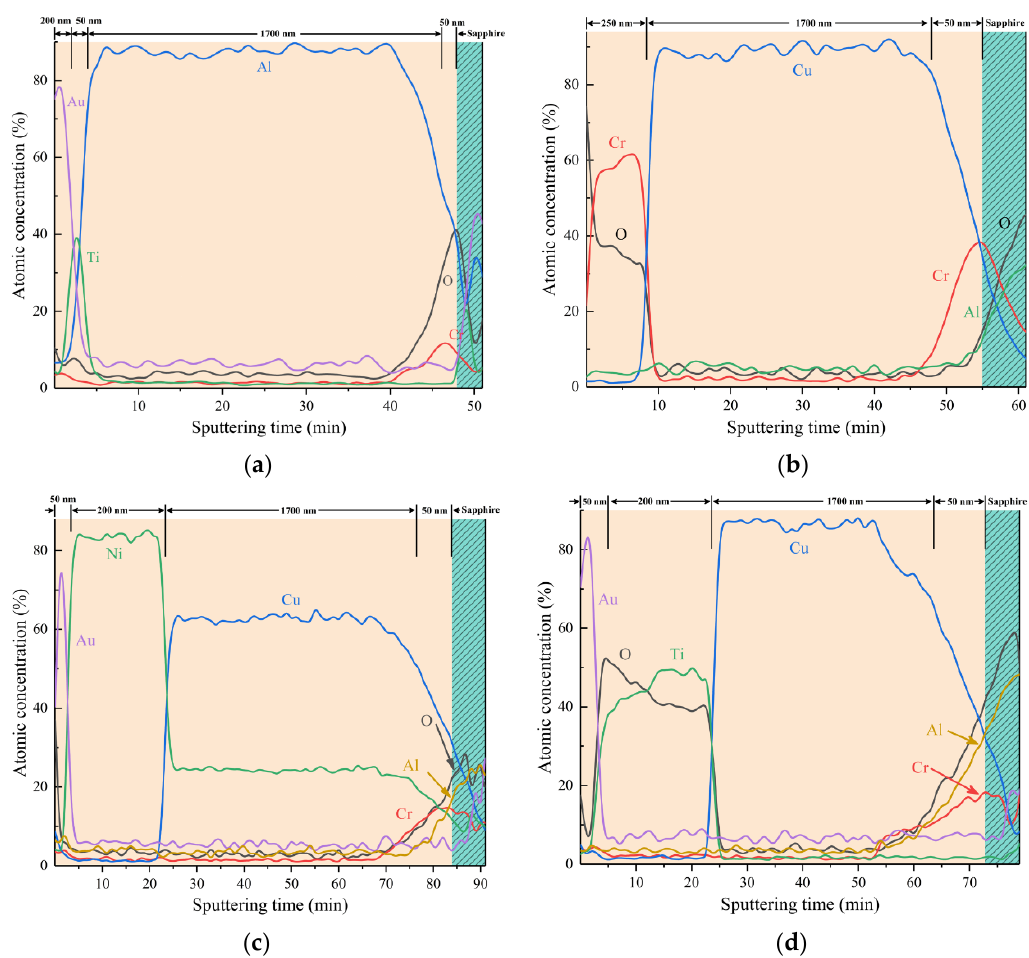
Figure 3. In-depth profiles of ( a ) Cr/Al/Ti/Au; ( b ) Cr/Cu/Cr; ( c ) Cr/Cu/Ni/Au and ( d ) Cr/Cu/Ti/Au using Auger electron spectroscopy in combination with in-situ ion sputtering.